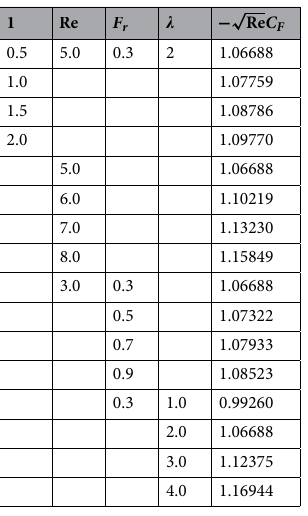
1 / 2 versus the different estimations of the mounting estimates of